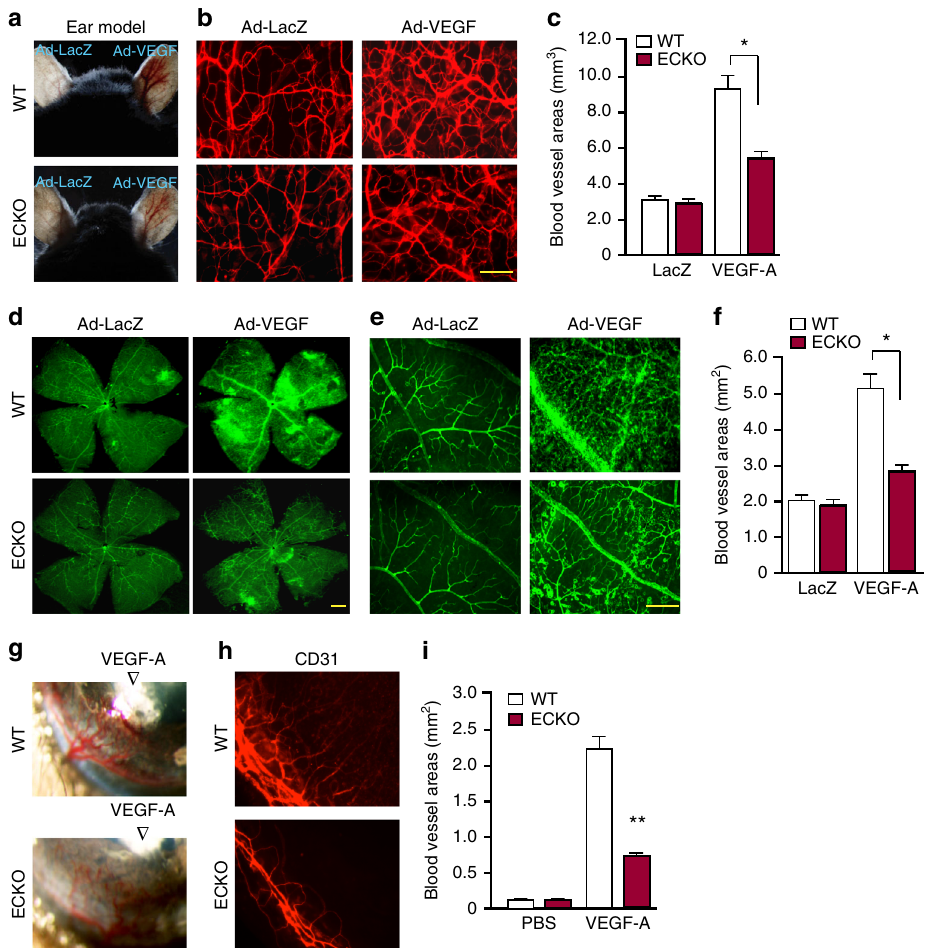
Fig. 2 VEGF-induced retina and cornea neovascularization were greatly attenuated in SENP1-ECKO mice. a – c VEGF-induced ear angiogenesis. Adenovirus encoding VEGF 164 (1 × 10 9 pfu) (Ad-VEGF) or β -galactosidase (Ad-LacZ) was intradermally injected into the mice right and left ear skin, respectively. a VEGF-induced angiogenesis in WT and SENP1-ECKO mice was accessed by a direct microscopy. b Ear vasculature was visualized by a whole-mount staining with PE-conjugated anti-CD31. c Quanti fi cation of vessel density from 10 fi elds per ear ( n = 5 for each group). d – f VEGF-induced retina angiogenesis. Ad-VEGF or Ad-LacZ (1× 10 9 pfu) was injected intravitreously into WT and SENP1-ECKO mice. Retina vasculature was visualized by isolectin staining (low power images in ( d ) and high power images in ( e ) with quanti fi cation of vessel density in ( f ). g – i VEGF-induced cornea angiogenesis assay. A Hydron pellet containing VEGF protein was implanted into the cornea of WT and SENP1-ECKO mice. Angiogenesis was assessed by stereomicroscopy on day 5 following implantation ( g ) and immunostaining with anti-CD31 ( h ). Vascular density was quanti fi ed in ( i ). Quanti fi caitons were from ten fi elds per tissue (ear, retina or cornea) ( n = 5 for each group). Error bars, mean± SEM; ∗ P < 0.05, ** P < 0.01, one-way ANOVA. Scale bar: 100 μ m ( b , e , h ); 400 μ m (